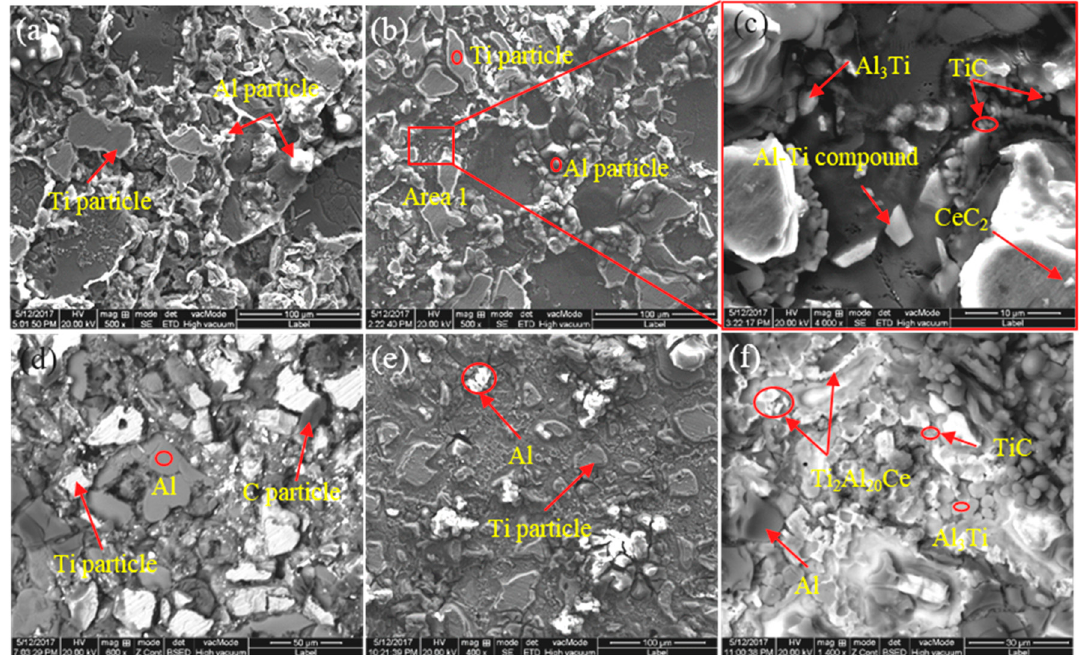
Figure 4. The microstructure of quenching samples with different CeO2 size at 60 s: ( a ) 30 nm; ( b ) 50 nm; ( c ) SEM image of Area 1; ( d ) 1 μ m; ( e ) low magnification image and ( f ) high magnification image of samples with CeO2 of the size of 2–4 μ m.